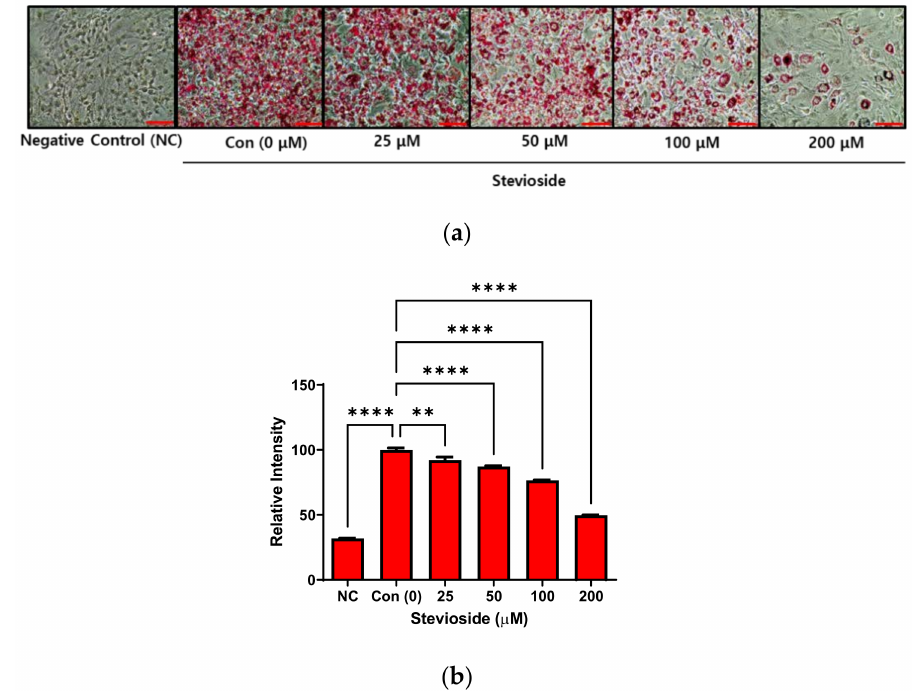
Figure 1. The effect of stevioside on lipid accumulation in 3T3-L1 cells. ( a ) Lipid droplets formation of stained with Oil Red O in 3T3-L1 adipocytes. Scale bar indicates 100 µ M. ( b ) The relative intensity of intracellular triglyceride in 3T3-L1 adipocytes. All data are presented as mean ± SD, and tests were performed in three independent experiments. ** p < 0.01 and **** p < 0.0001. Negative control (NC) was not treated with an adipocyte differentiation cocktail.